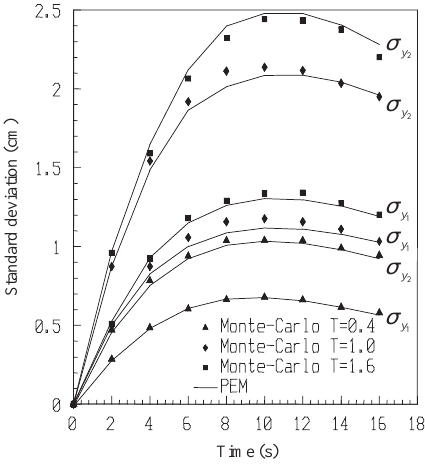
Fig. 3. Displacement standard deviation comparison for different time lags.